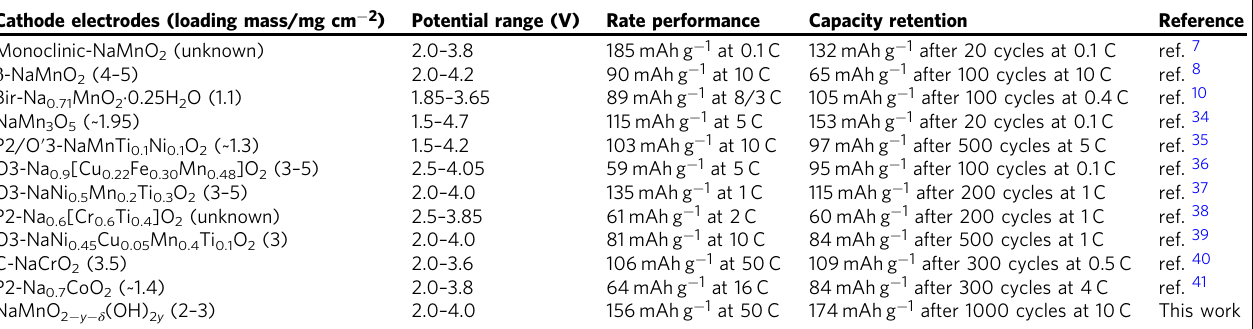
respectively. The Raman spectra of the S1 – S4 samples show three major peaks between 500 and 700 cm – 1 , corresponding to the ν 3 (Mn – O) stretching vibration, ν 2(Mn – O) stretching vibration, and ν 1(Mn – O) symmetric stretching vibration in the basal plane of edge-shared MnO 6 octahedra, respectively 15 . With the increasing of Na content in the birnessite-Na x MnO 2 − y (OH) 2 y , ν 1 and ν 2 vibrations of MnO 6 groups shift to higher energies 16 , indicating the decrease of the average Mn oxidation state. For the S4 sample, ν 1 and ν 2 vibrations locate at higher energies compared to those of the S3 sample, implying even lower Mn oxidation state of the S4 sample. Due to the same Na content in both S3 and S4 samples, the lower average Mn oxidation state suggest the existence of O vacancies in the S4 sample. As shown in Supplementary Fig. 3a (Standard X-ray absorption near edge structure (XANES) spectra of Mn L II,III -edges for MnO and Mn 2 O 3 are also included as reference), the Mn L II,III -edge shifts to NATURE COMMUNICATIONS| (2018) 9:5100 |DOI: